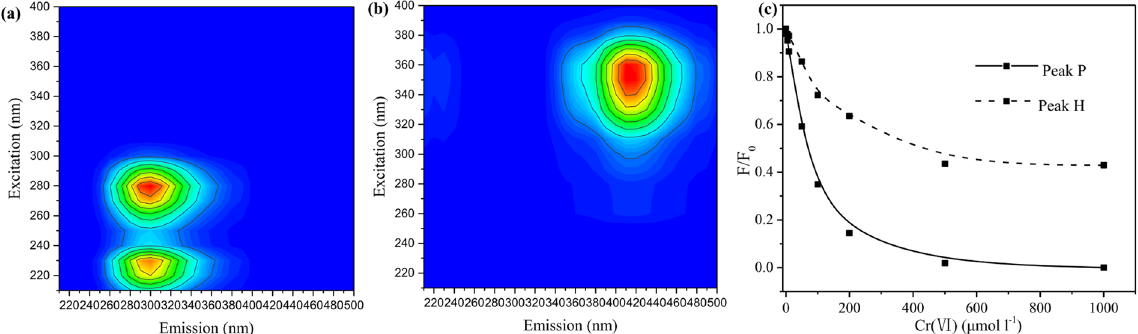
Figure 4. EEM spectra of two main fluorescence components obtained from PARAFAC analysis. ( a ) proteins- like substances; ( b ) humic-like substances; ( c ) their peak intensities of the EEM spectra at various Cr 6 + dosages obtained from PARAFAC analysis.